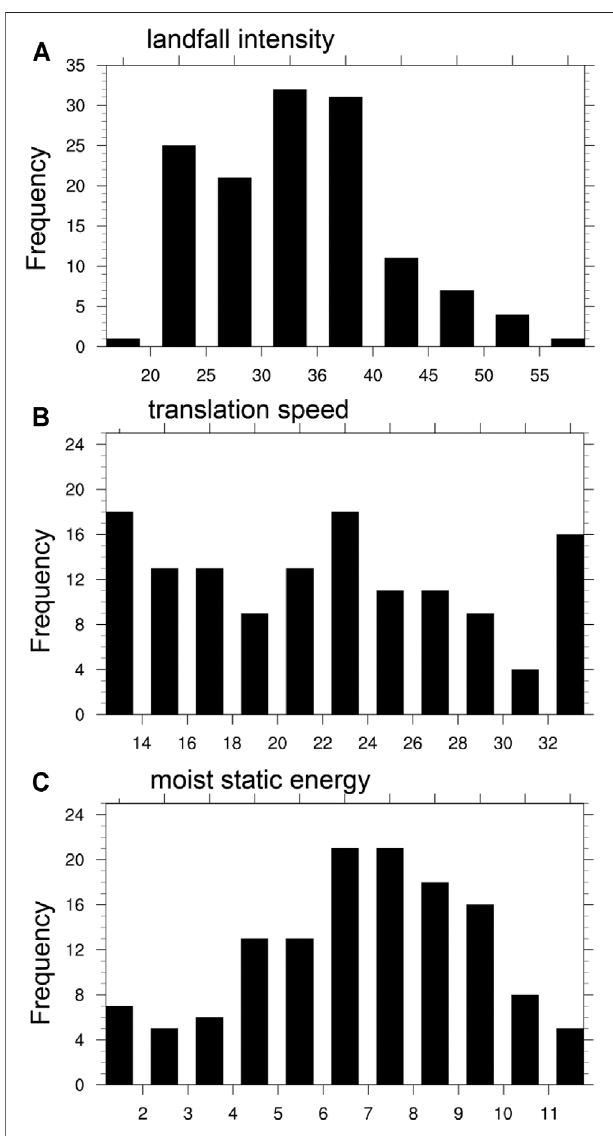
FIGURE 6 | Distribution of (A) the landfall intensity (m s − 1 ), (B) the translation speed at landfall (km h − 1 ), and (C) the mean 850 hPa moist static energy at landfall ( Δ ∅ m , 10 3 J Kg − 1